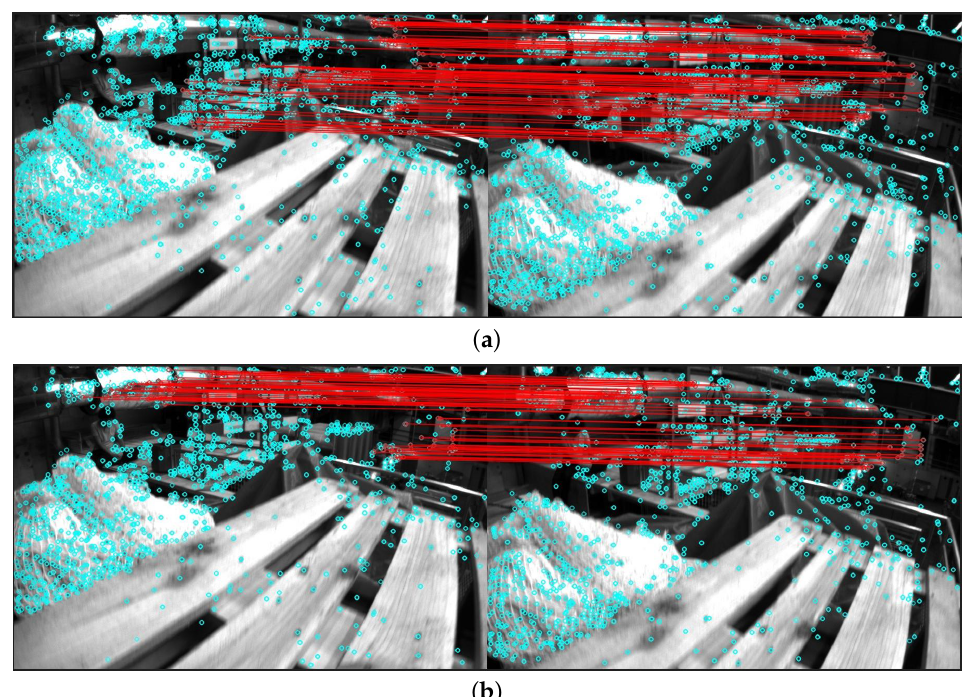
Figure 10. The matching results of the 11th group of pictures. ( a ) The matching results of the SIFT algorithm; ( b ) the matching results of the algorithm in this